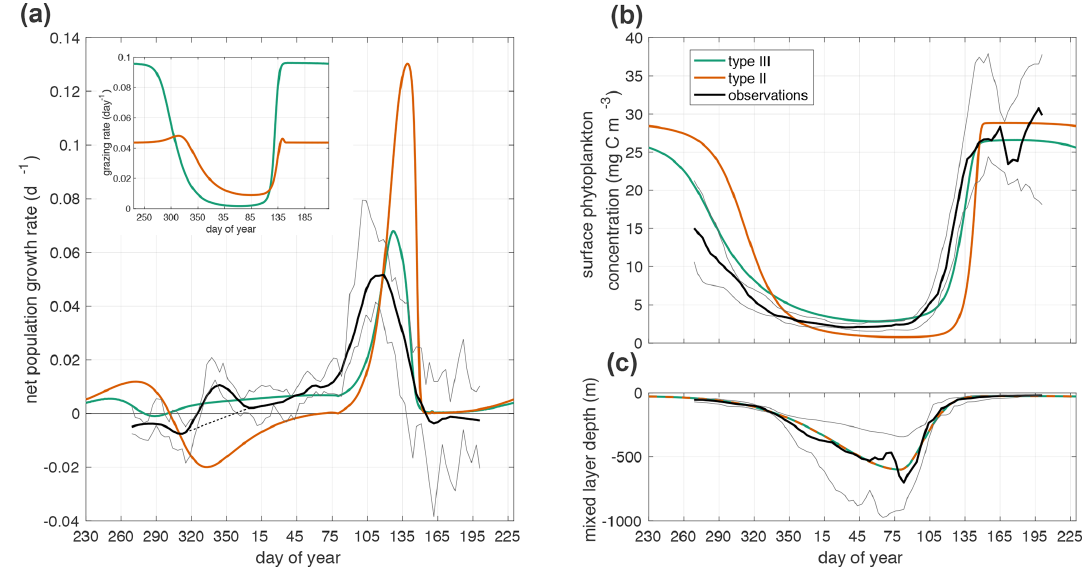
Figure 3. (a) Net mixed layer population growth rate in observations and model. Inset is grazing rate g(p) . The thin dashed black line from day 315 to day 4 shows the interpolated growth rate used in parameter fitting. (b) Annual cycle of phytoplankton surface concentration in observations and model simulations. (c) Mixed layer depth ( − H(t) ). The observations, black line, are the median quantity measured by Argo floats with the interquartile range shown in grey lines. The green line is the prediction of the model in Eq. 1 with a Holling type III functional response. The orange line is the prediction of the model with a Holling type II functional response. Table 1. Parameters used in Figs. 2, 3, and 4. Parameters above the line were prescribed based on literature values. Parameters below the line were fit by linear least squares parameter fitting of the phytoplankton growth rates. The final section lists the expressions used in Fig. 2. The P integrated growth rate used in the ratio of grazing to growth is µ 0 K d H